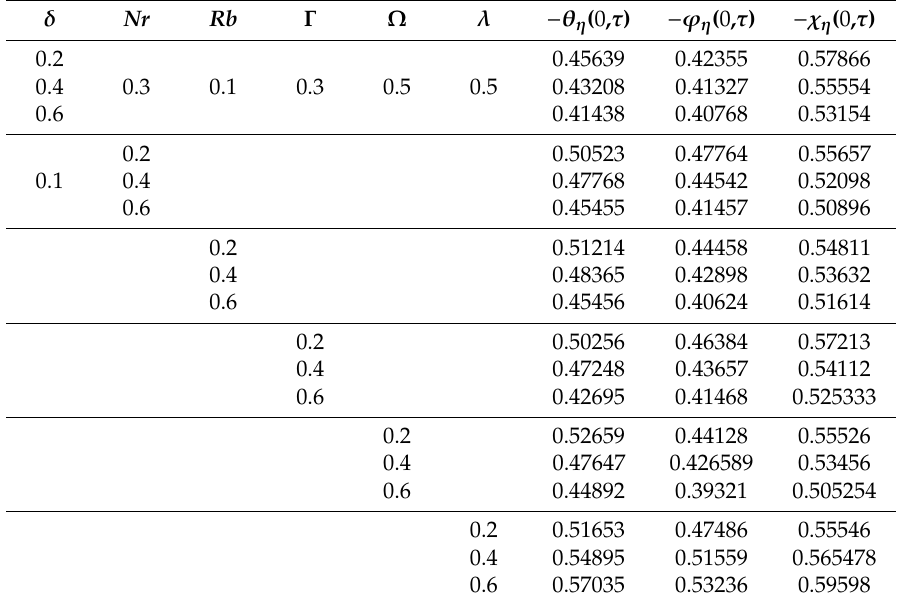
1/2 Re C for ( a ) Γ and ( b ) . δ . x f